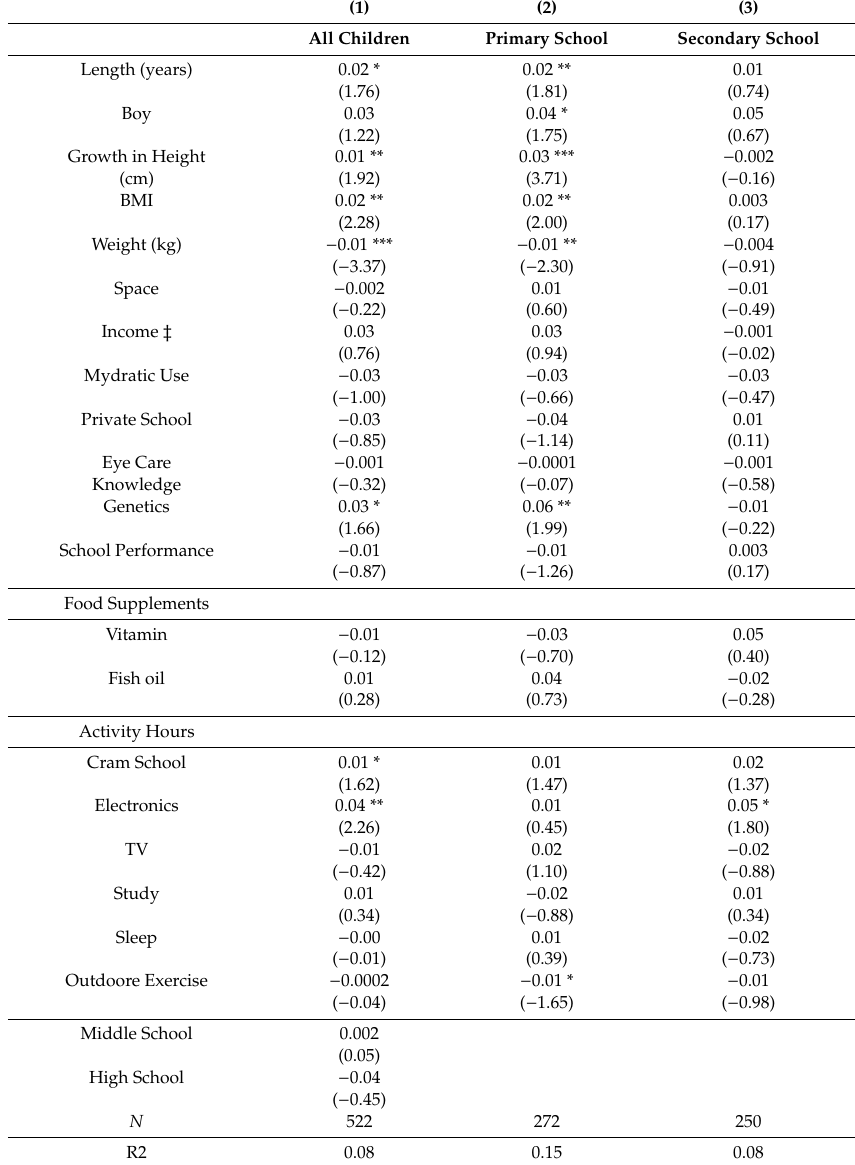
Table 5. Regression analysis of factors that explain the progression of myopia †